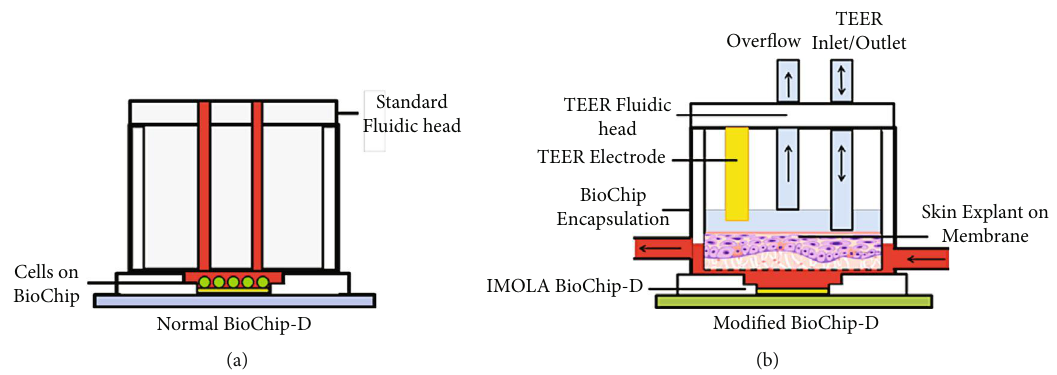
Figure 23: Schematic diagrams: (a) standard biochip with fl uidic head and (b) modi fi ed biochip. Reproduced (or adapted) with permission [119], ©2018,